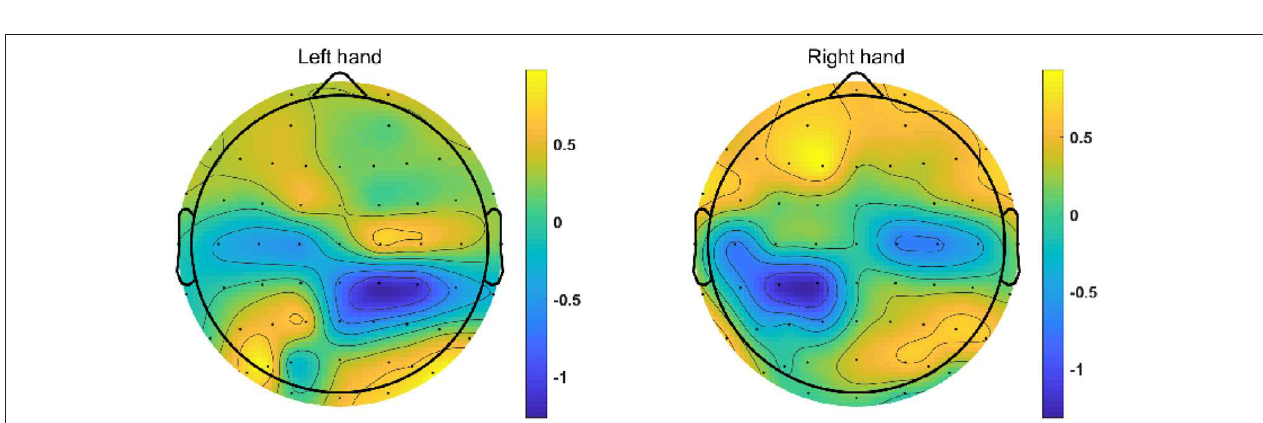
FIGURE 6 | Topographic maps of 2 MI missions from participant “l1”. These graphs are obtained using the ERSP value of every channel and interpolation between the channels. The blue area indicates that an ERD phenomenon occurs in the corresponding brain area when the subject performs the motor imagery task.